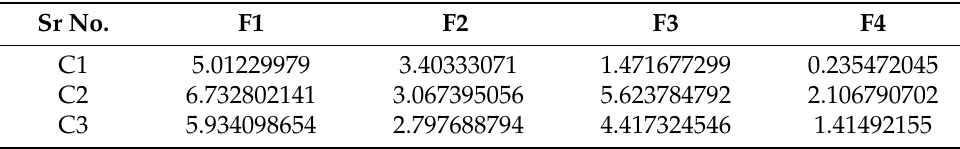
Table 19. The best centroids for Iris obtained by proposed approach.